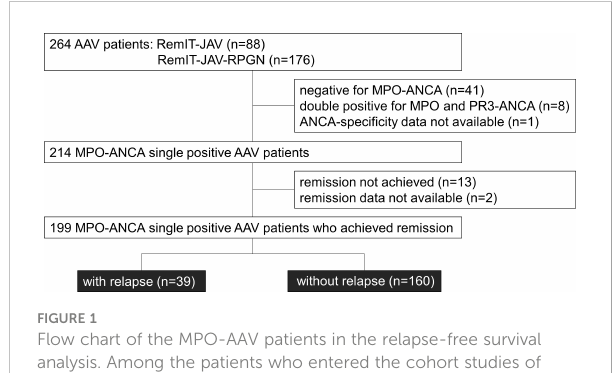
FIGURE 1 Flow chart of the MPO-AAV patients in the relapse-free survival analysis. Among the patients who entered the cohort studies of remission induction therapy (RemIT-JAV and RemIT-JAV-RPGN), 199 MPO-ANCA positive and PR3-ANCA negative ( “ MPO-ANCA single-positive ” ) patients who achieved remission were studied in the relapse-free survival